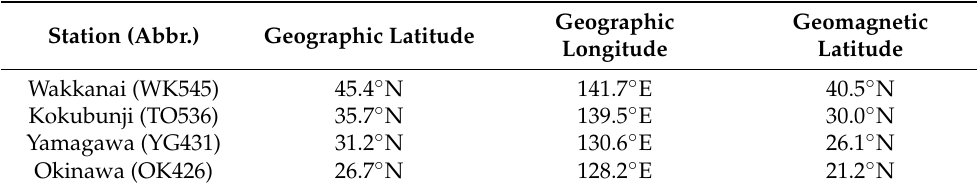
Table 1. Coordinates of ionosonde stations used in this study. Geomagnetic latitude are obtained from the International Geomagnetic Reference Field (IGRF)-2005 magnetic field model. Station (Abbr.) Geographic